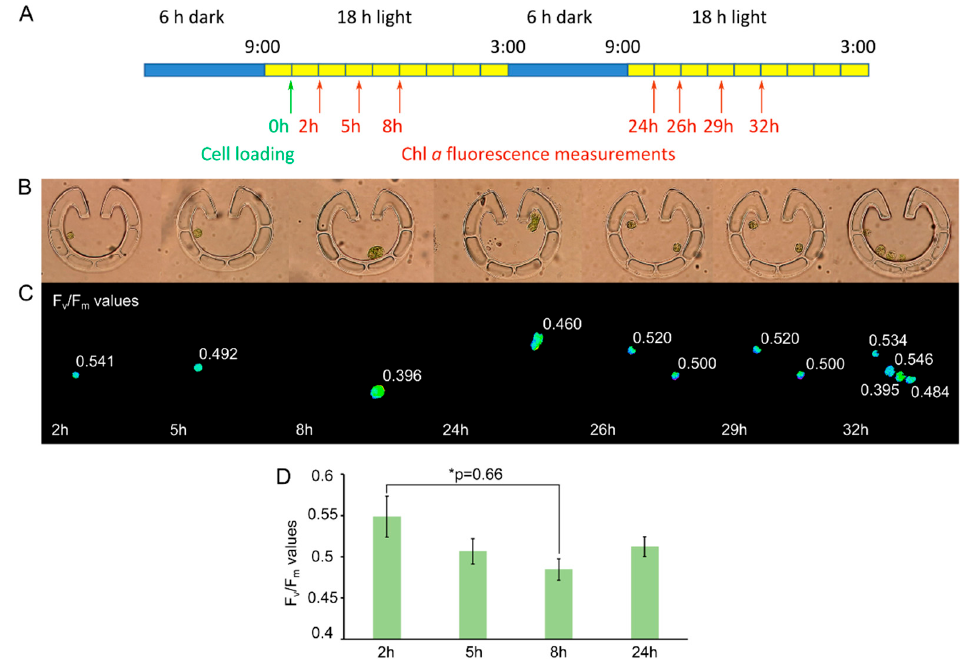
Figure 5. Cell division in “Pot” trap Type VI. ( A ) Scheme of the dark–light cycles and the time of cell loading (green arrow) and Chl a fluorescence measurements (red arrows). ( B ) Bright-field images of the traps with C. reinhardtii cells at the indicated times. ( C ) F V /F M values taken at the indicated times. A representative example is shown. Images were taken by using a Plan-Neofluar 63×/1.25 Oil objective. ( D ) Averages of F V /F M values (n = 10 to 13) as determined in Figure 5C, originating from six independent experiments. One-way ANOVA with Dunnett multiple comparison test using the 2-h sample as control indicates significant differences at p < 0.1 level.